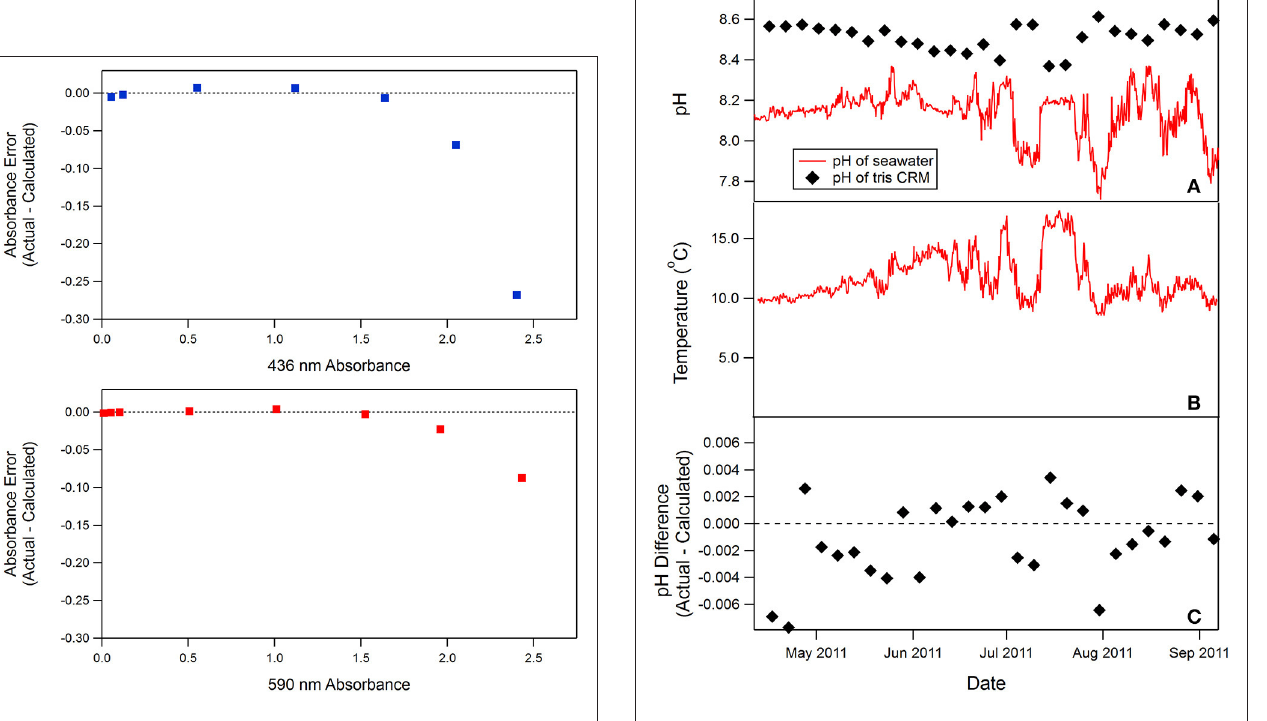
FIGURE 2 | Absorbance linearity of the SAMI optical system at the wavelengths used for BCP in the SAMI alkalinity system (Spaulding et al., 2014). Absorbances were measured for BCP solutions with concentrations ranging from 1.4 × 10 − 7 to 3.4 × 10 − 5 M at 590nm (pH = 10.5) and 2.09 × 10 − 6 to 1.04 × 10 − 4 M at 436nm (pH = 3.0). A linear fit to absorbance vs. concentration data up to 1.0a.u. was used and the residuals (y-axis data) were calculated relative to the linear equation.